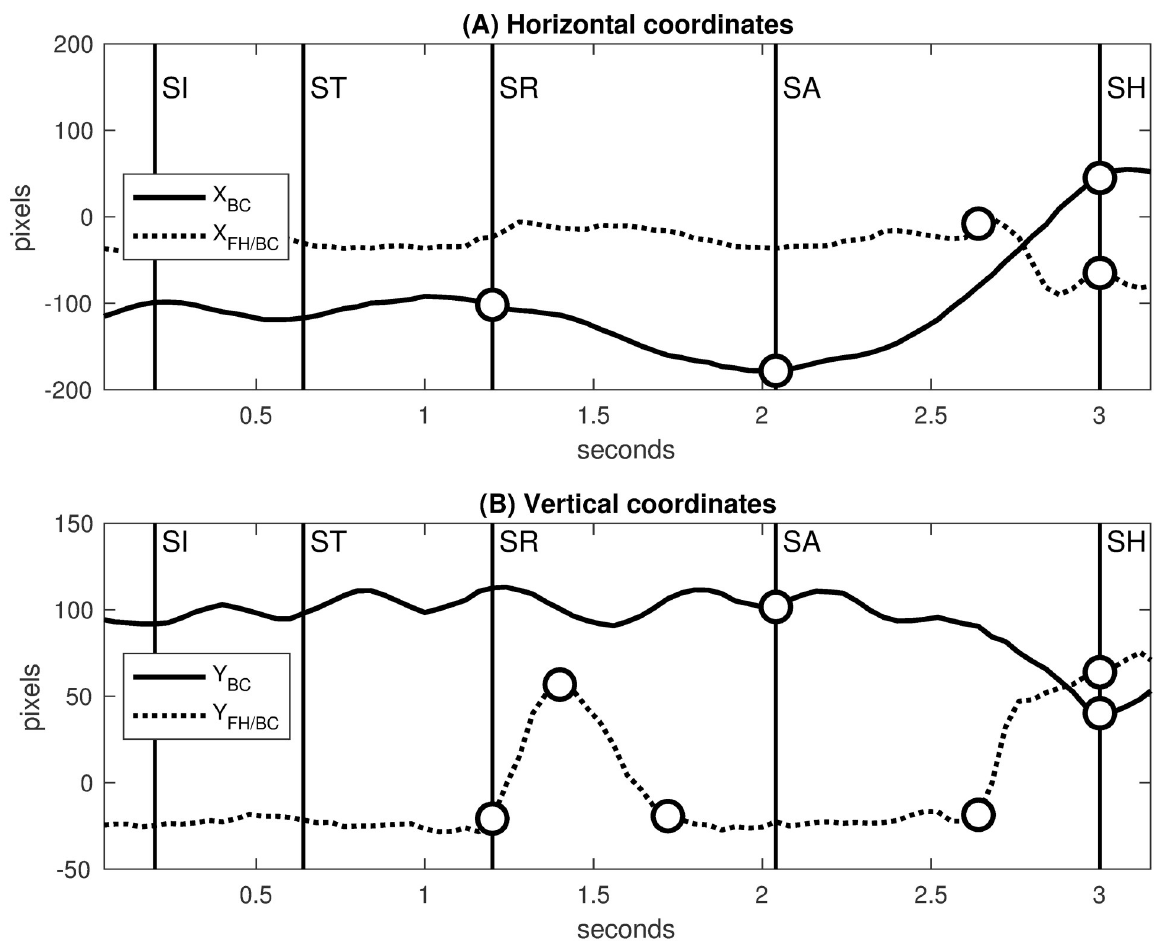
Fig 24. Trajectories of Steffen’s body center and free hand. Decisive movements are delimited by white dots (variation changes). (A) Horizontal coordinates of body center ( X BC , solid line) and free hand relative to body center ( X FH/BC , dotted line). (B) Vertical coordinates of body center ( Y BC , solid line) and free hand relative to body center ( Y FH/BC , dotted